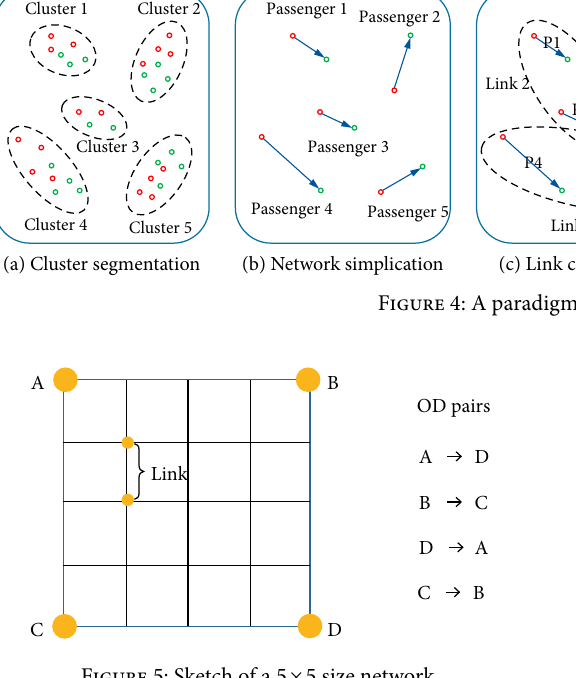
Figure 5: Sketch of a 5 × 5 size